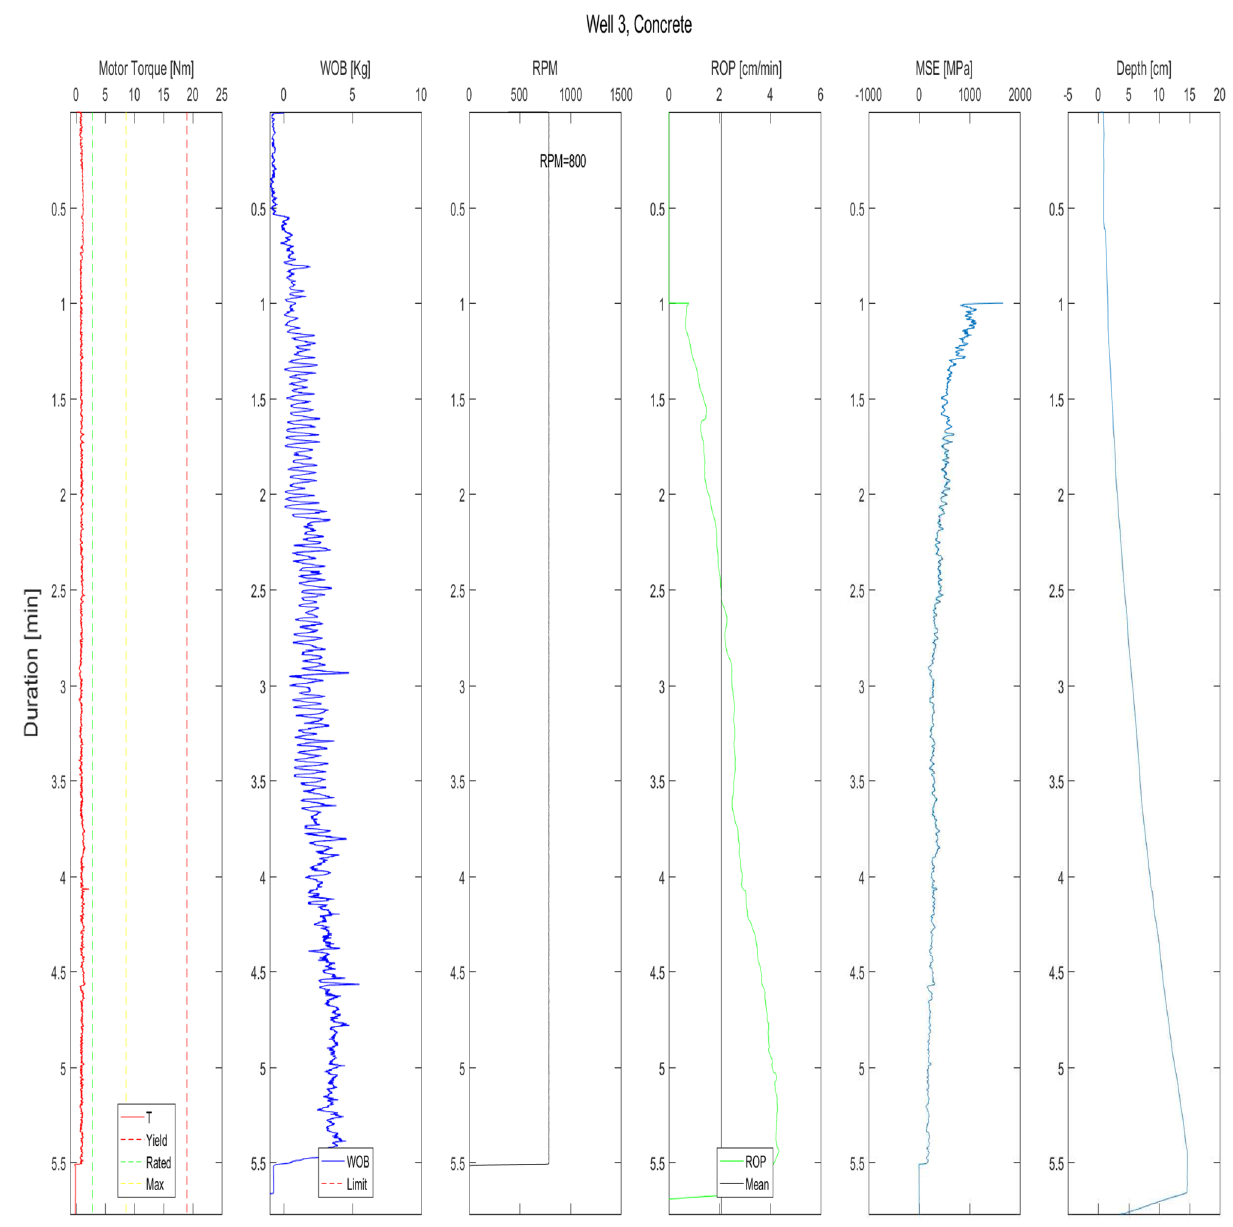
Fig. 12 Well Concrete 3, manual mode with varying WOB (RPM =